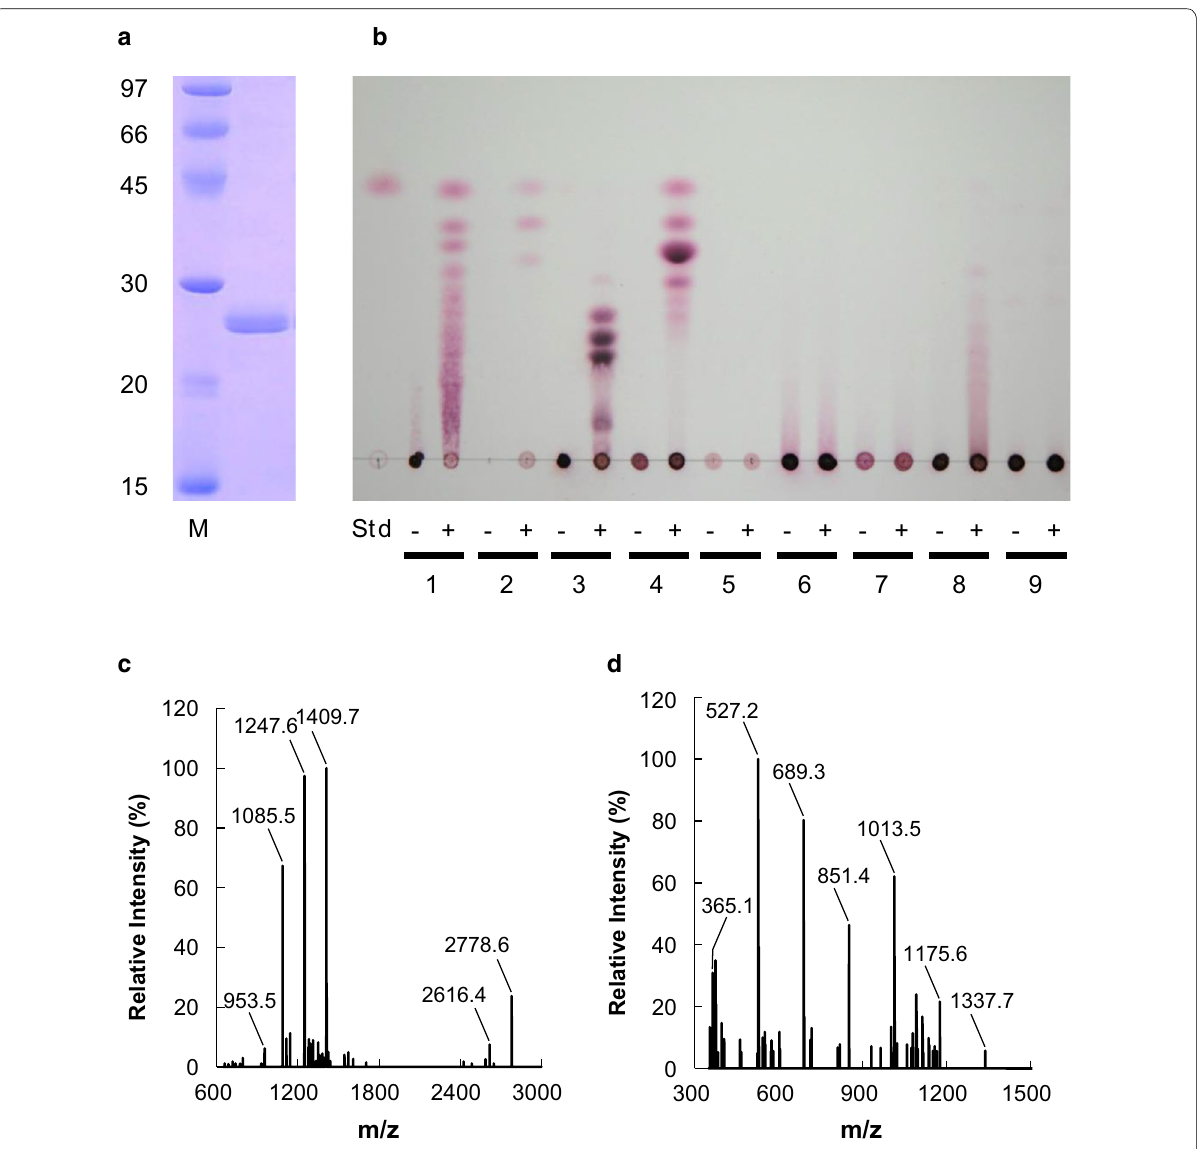
Fig. 4 SDS-PAGE of recombinant GH12 enzyme, and TLC and MALDI-TOF–MS analyses of reaction products. a Purified enzyme (1 μg) resolved by SDS-PAGE stained with Coomassie brilliant blue. Lane 1, GH12 enzyme deglycosylated by EndoH; Lane M, protein molecular mass makers. b TLC analysis of soluble products in reaction mixtures with ( ) and without ( ) enzyme using CMC (lane 1), MCC (lane 2), xyloglucan (lane 3), lichenan + − (lane 4), curdlan (lane 5), laminarin (lane 6), pustulan (lane 7), glucomannan (lane 8), or galactomannan (lane 9) as the substrate. GH12 enzyme was incubated with 1.0% substrate in 50 mM acetate buffer (pH 3.0) at 50 °C for 60 min. c , d Reaction products from xyloglucan ( c ) and lichenan ( d ) were identified using